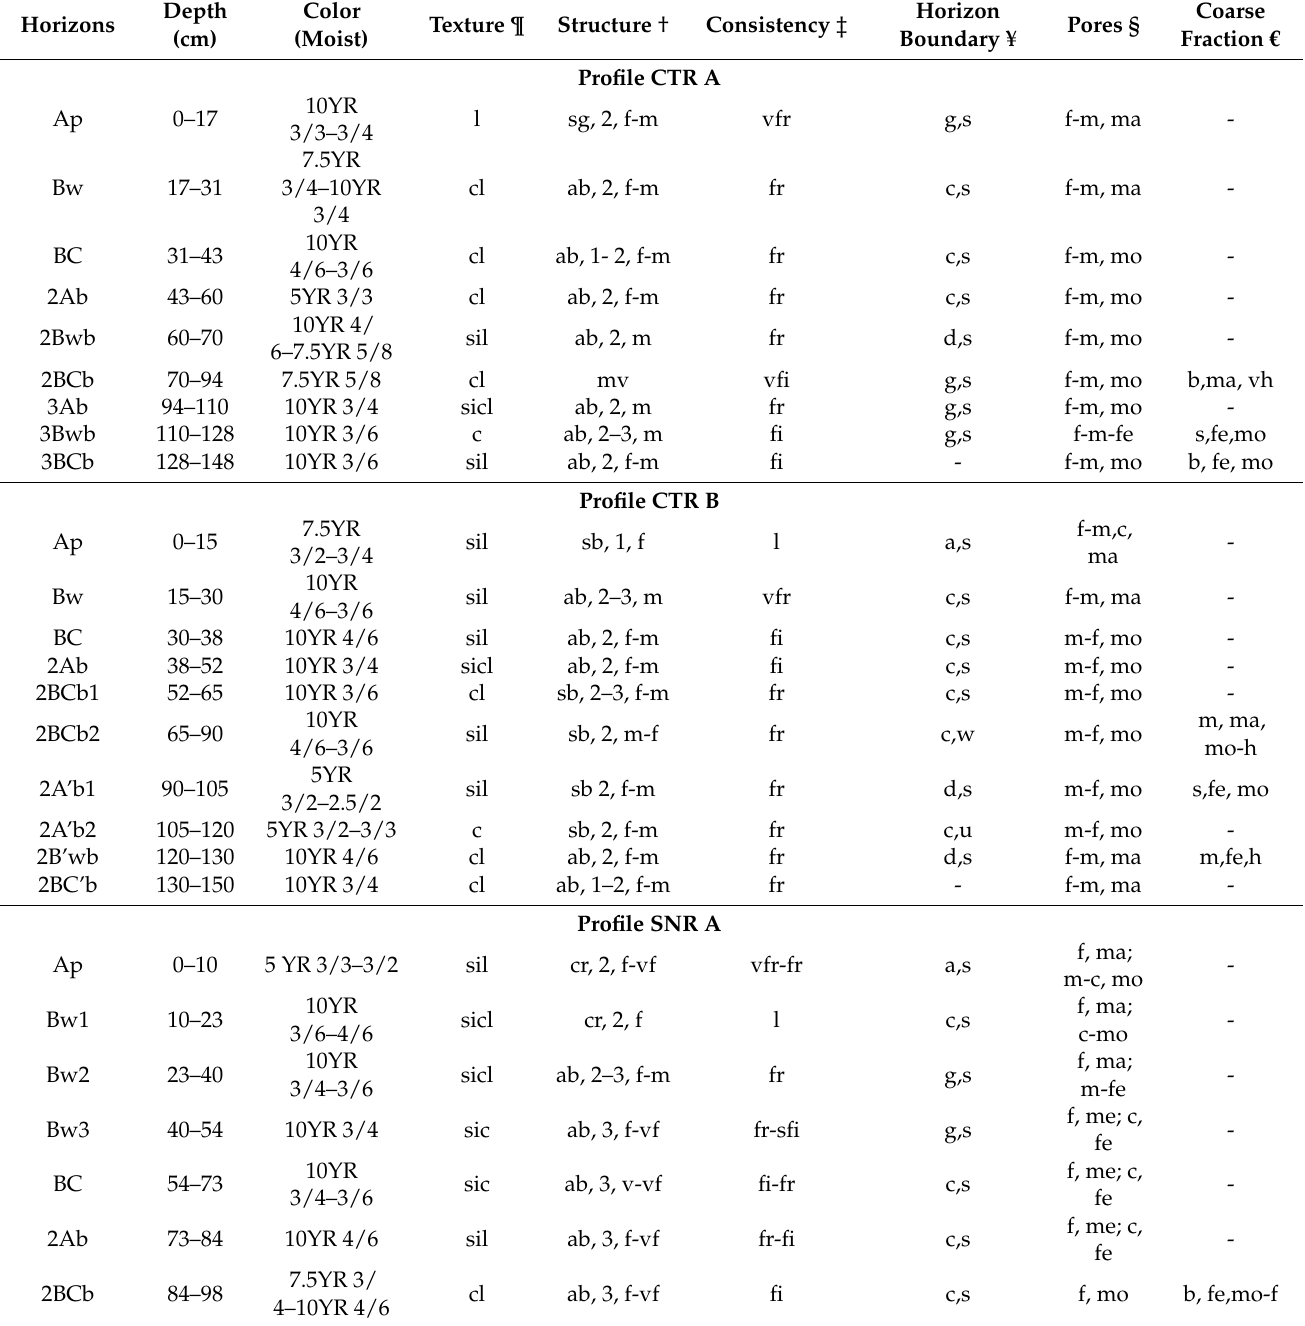
Table 2. Morphological properties of soils with different agro-climatic zones, types, and ages of parent